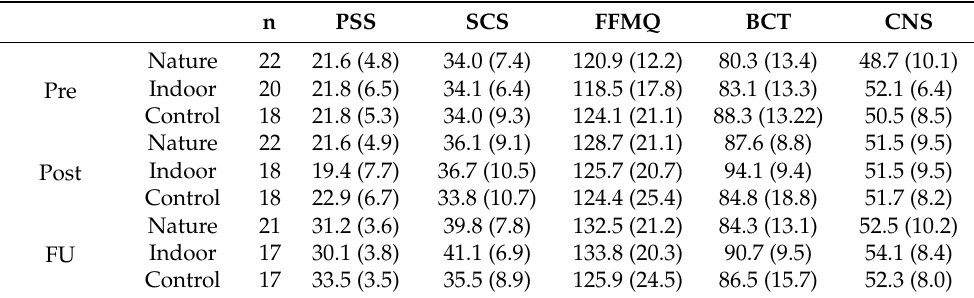
Table 5. Means and standard deviations for all outcomes pre-intervention, post-intervention, and at 3-month